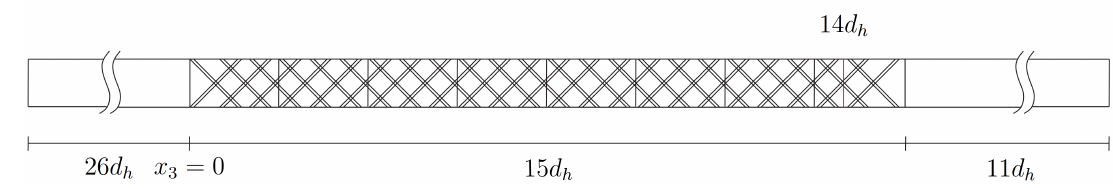
Figure 2. Parameter and overview of ribbed configuration.